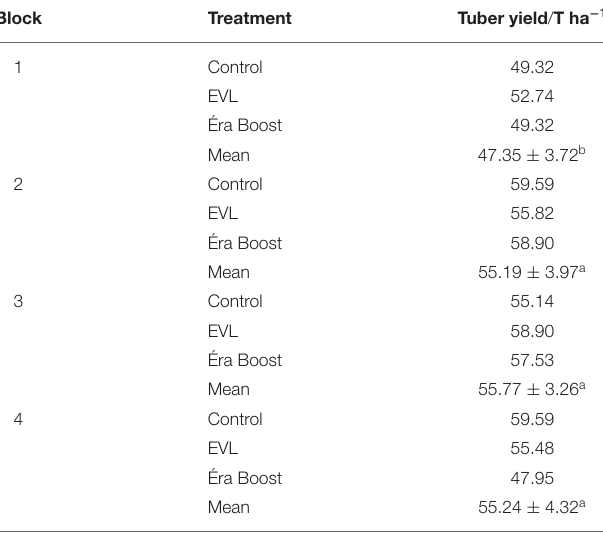
TABLE 1 | Tuber yield in sampled plots and block means of harvested plots.